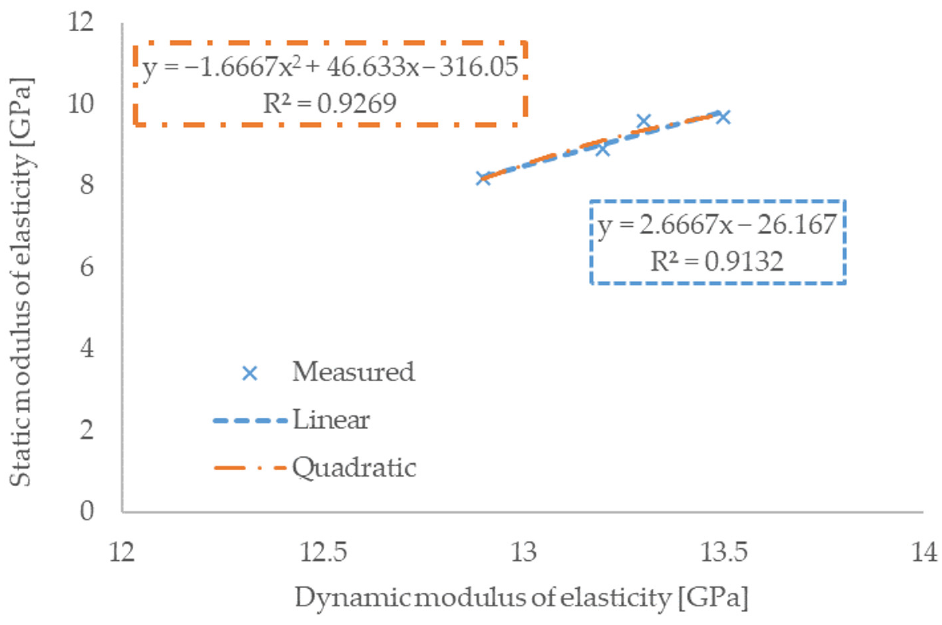
Figure 5. The relationship between dynamic modulus of elasticity and static modulus of elasticity.